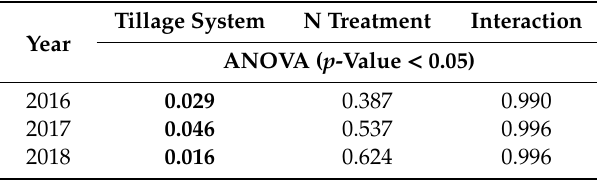
Table 2. Analysis of variance results for tillage system, nitrogen (N) treatment, and interaction e ff ects on lint yield in 2016, 2017, and 2018.